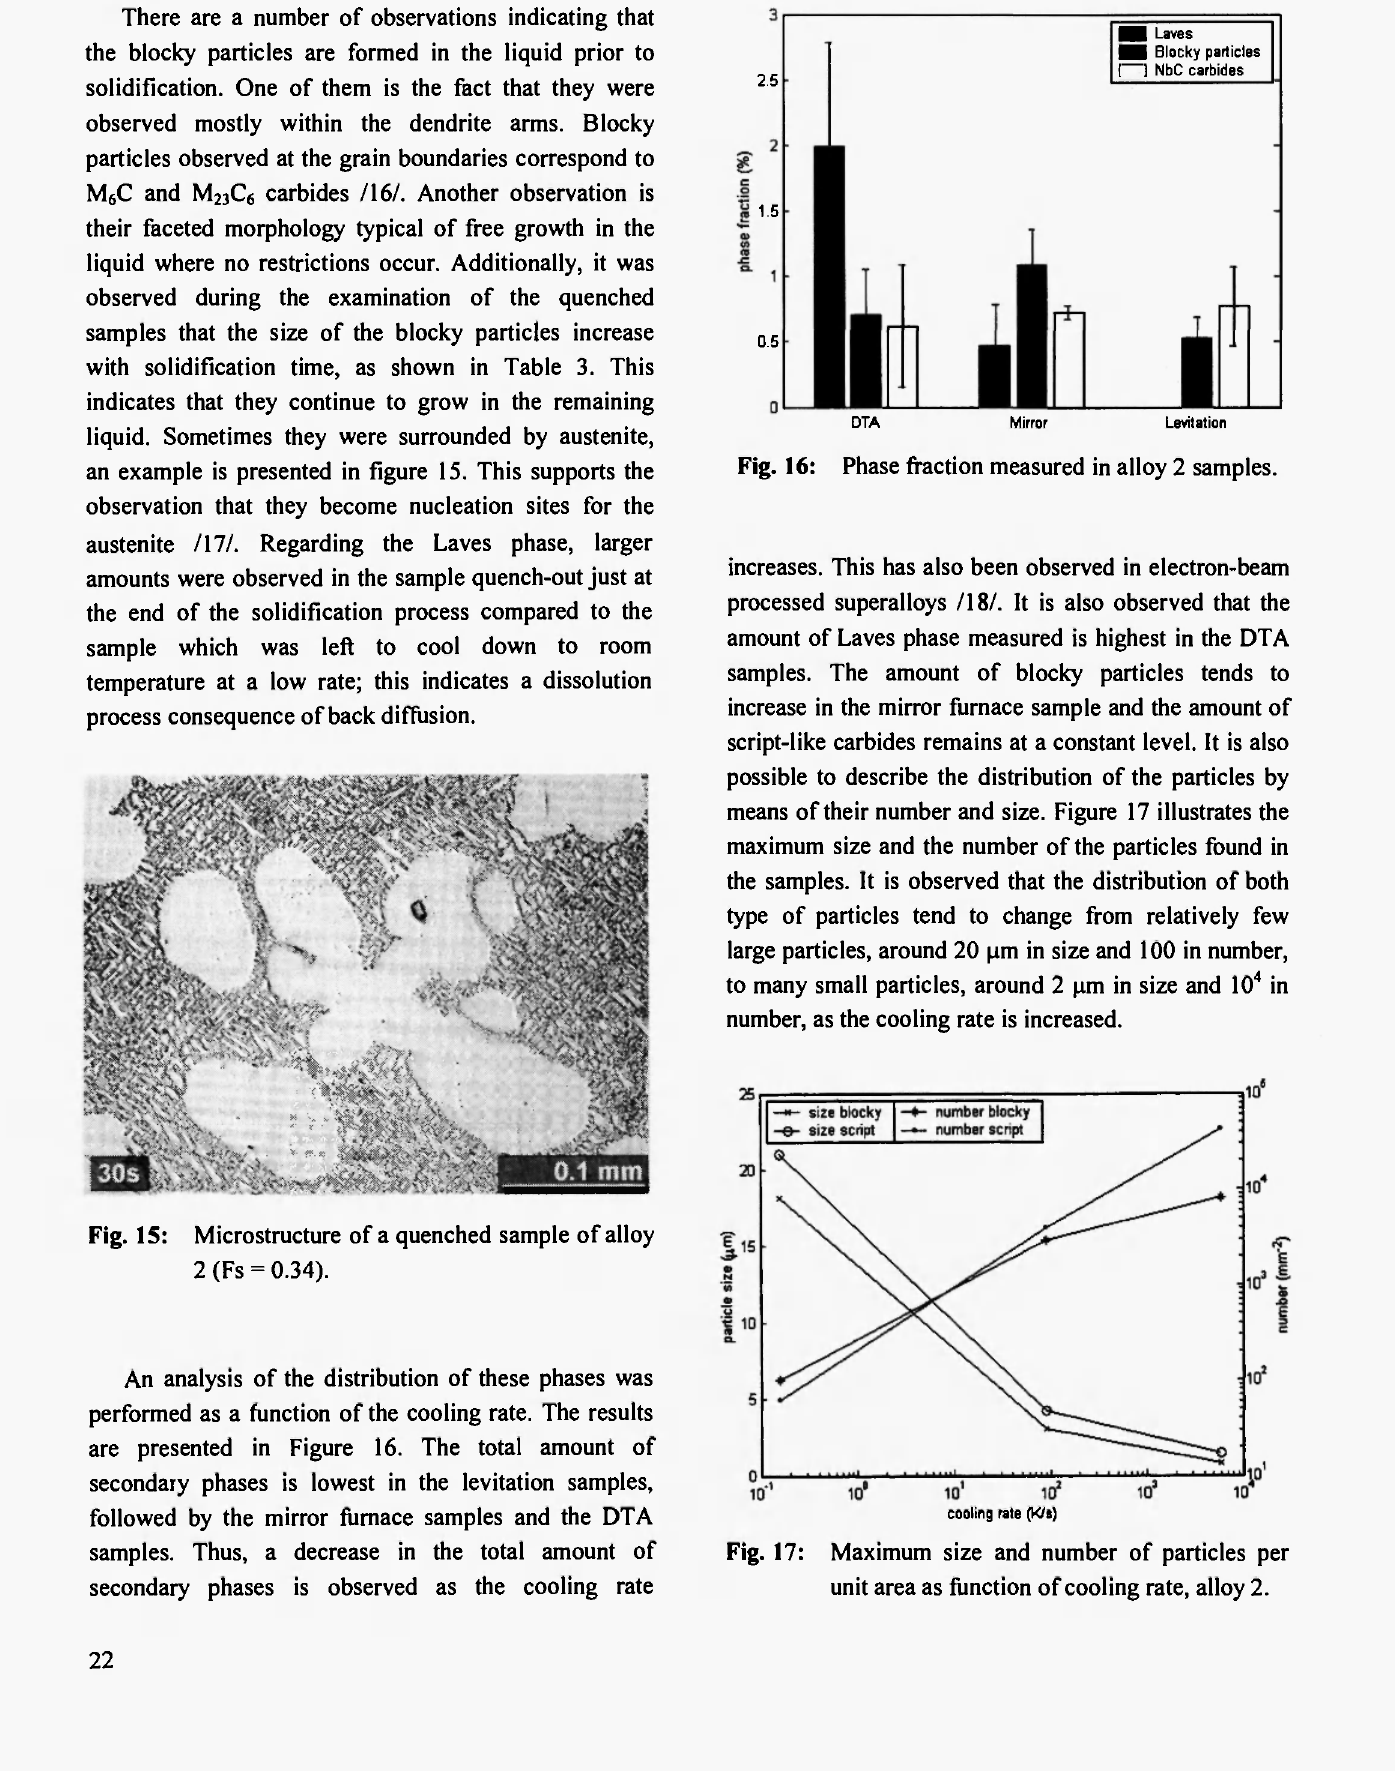
Fig. 17: Maximum size and number of particles per unit area as function of cooling rate, alloy